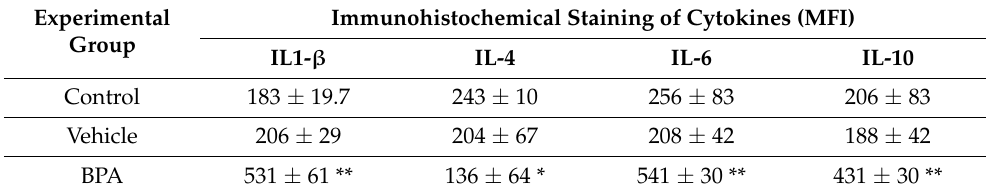
Figure 1. Intratumoral expression of cytokines. Representative images belonging to the intratumoral expression of IL-1 β , IL-4, IL-6, and IL-10 corresponding to the three experimental groups, namely control, vehicle, and BPA, are shown. The staining was performed with rhodamine and pictures were taken in a confocal microscope, using Newarsky contrast, being red the cytokine expressed and gray the not stained tumor. Table 1. Summary of the quantitation of immunofluorescence cytokine (IL1- β , IL-4, IL-6, and IL-10) staining in tumors. It shows the obtained MFI (Mean Fluorescence Intensity) ( ± SD) of the different experimental groups. It is highlighted the results that were considered statistically significant * p < 0.05, ** p < 0.01. Of note, only IL-4 decreased its expression in the BPA neonatally treated group.